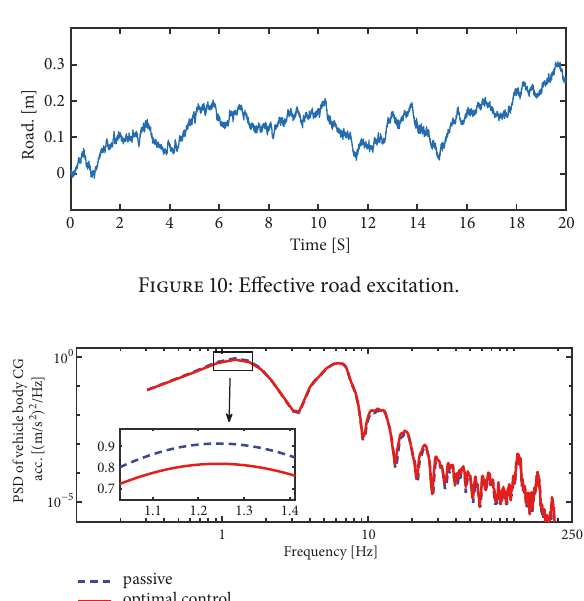
Figure 6: Frequency response of airgap eccentricity.